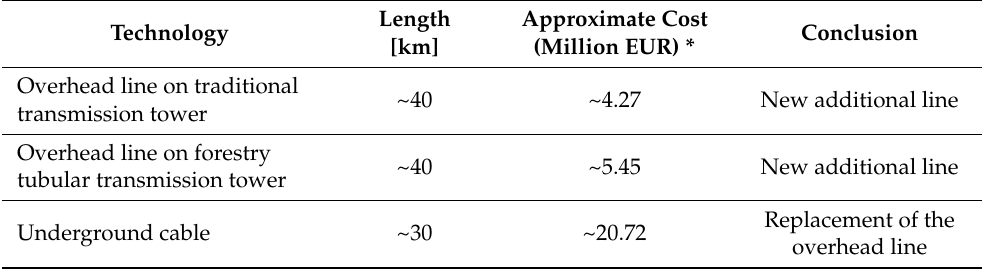
Table 17. Approximate cost of implementing or replacing the 110 kV line. Length Technology